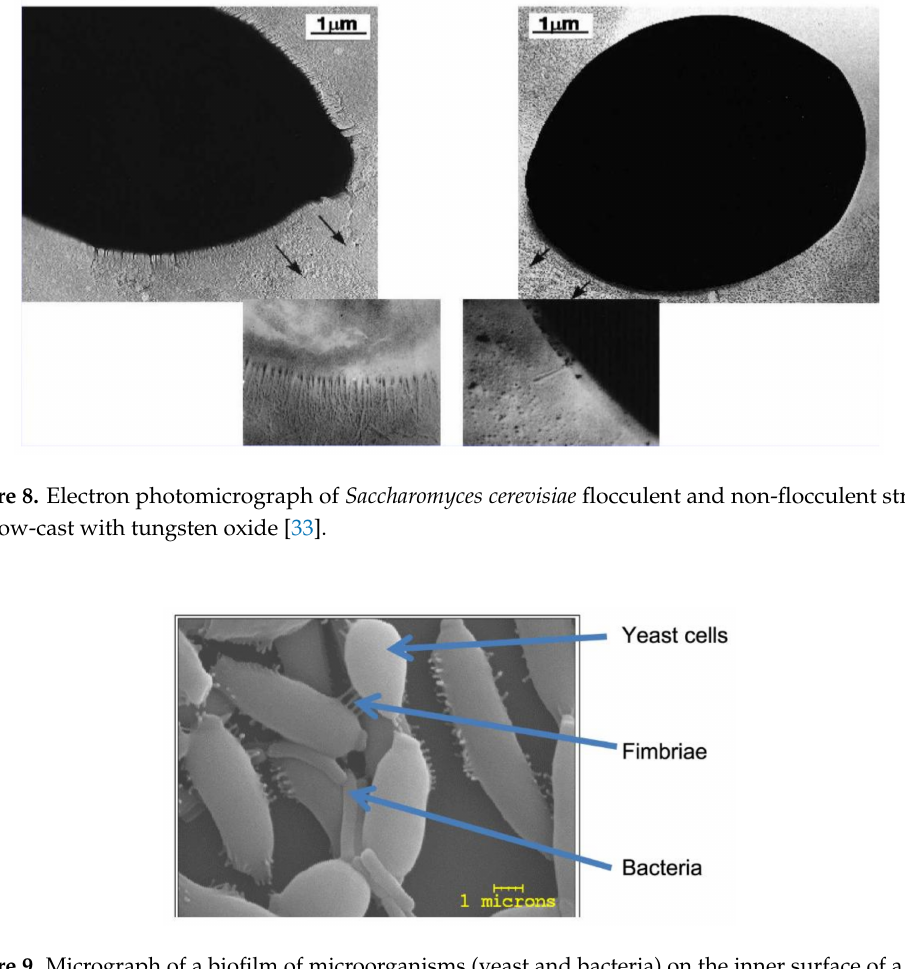
Figure 9. Micrograph of a biofilm of microorganisms (yeast and bacteria) on the inner surface of a beer dispersing line